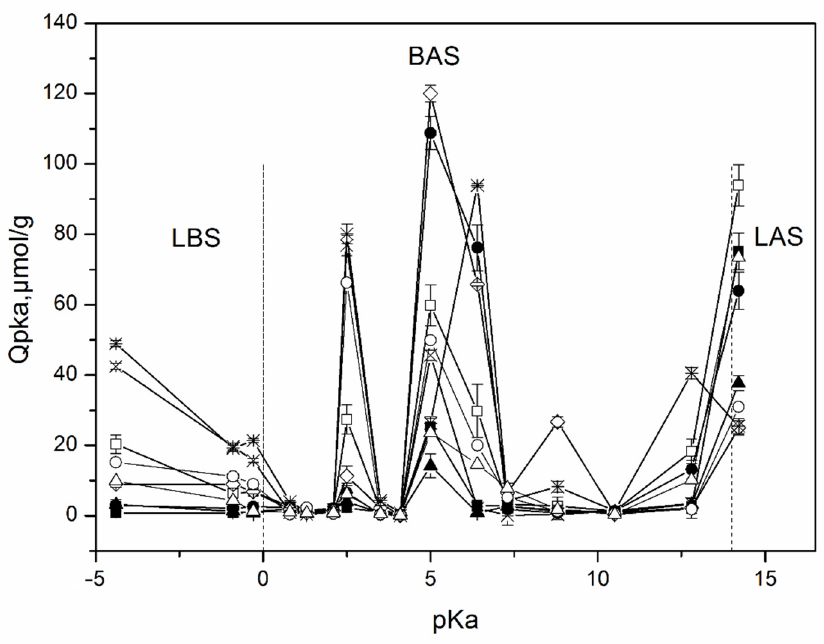
Figure 4. Distribution of the adsorption centers as a function of their pKa values on the surface of aluminosilicate samples and activated carbon: ◊ —MT-Al0; ○ —MT-Al0.2; △ —MT-Al1.0; ● —Kaol- sph; ▲ —Kaol-sponge; □ —Kaol-pl; ⬛ —Hal; ×—Beta; ⚹ —activated carbon. LBS—Lewis basic sites; BAS—Brønsted acidic sites; LAS—Lewis acidic sites.